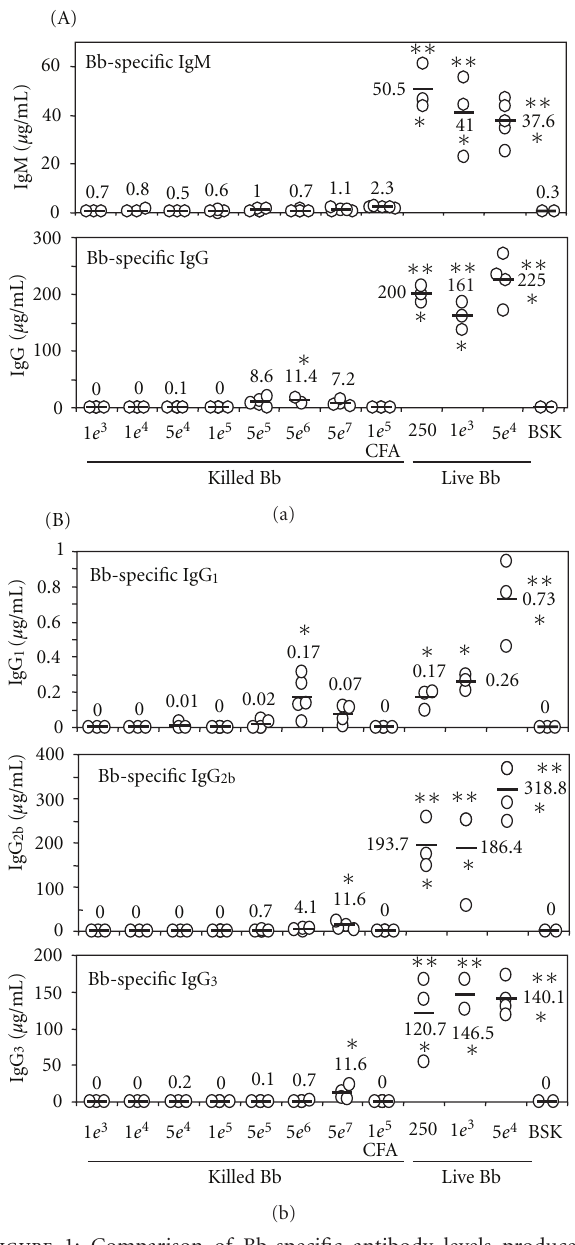
Figure 1: Comparison of Bb-specific antibody levels produced during active infection versus exposure to high numbers of killed bacteria. (a) Groups of B6 mice were injected with a single dose of live or heat-killed Bb, and serum was collected at either 2 or 4 weeks after infection; in some cases the killed Bb inoculum included an equal volume of complete Freund’s adjuvant (CFA). The doses injected ranged from 1000 (“1 e 3 ”) to 5 × 10 7 (“5 e 7 ”) killed bacteria, and 250 to 5 × 10 4 (“5 e 4 ”) live Bb. Individual sera were assessed for Bb-specific IgM content at 2 weeks after infection and for IgG content at 4 weeks after infection by ELISA analyses. Each circle represents the serum value for an individual animal, and the number beside the bar indicates the average value for that group. ∗ indicates values that are significantly di ff erent from control mice (Un); ∗∗ indicates values that are significantly di ff erent from mice injected with killed bacteria. (b) The sera assessed for IgG content in (a) were also assessed for the levels of the indicated individual IgG isotypes using similar ELISA